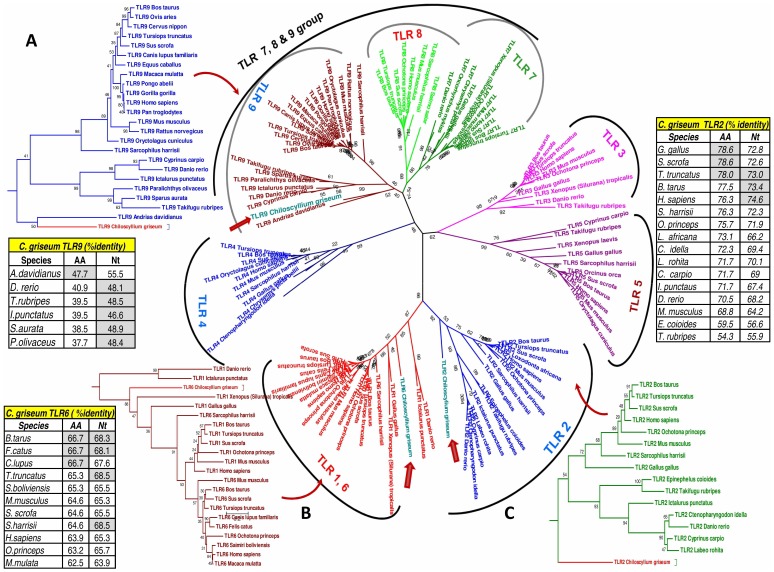
Phylogenetic relationship of the toll like receptor type transcripts of Chiloscyllium griseum identified from the transcriptome data.The sequences of the TLR types TLR2 (1410 nt), TLR6 (2436 nt) and TLR9 (1431 nt) of C. griseum was aligned with the other sequences as listed in the Table S1 from GenBank representing the TLR types from different lower and higher order species using Clustal W (codons) algorithm in MEGA 5.0. The corresponding nucleotide and amino acid identity of the C. griseum transcript is provided in the insert table for each TLR type Note: The grouping of the TLR2 and TLR6 of C. griseum with the bacterial PAMP recognizing TLR group (namely the TLR1, 2, 4, 5 & 6) while the TLR9 groups itself with the TLR7, 8 & 9 family.